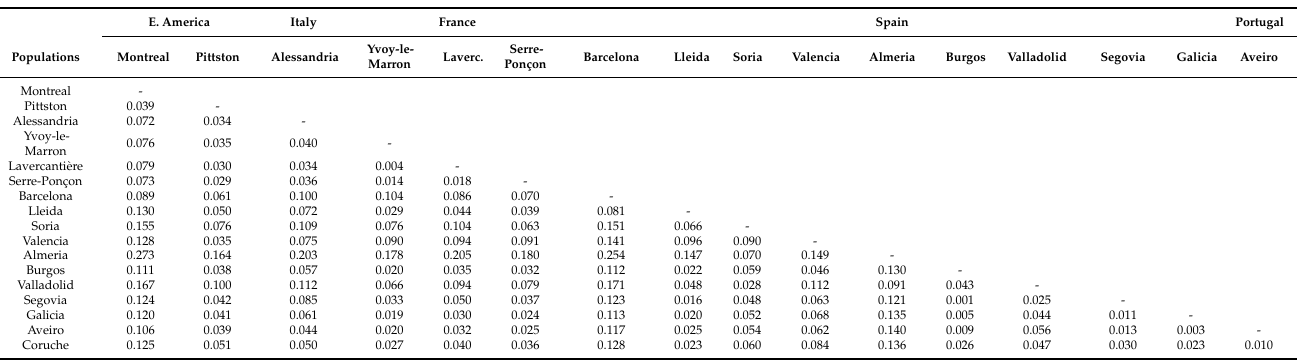
Table 2. Estimates of pairwise F ST for Leptoglossus occidentalis